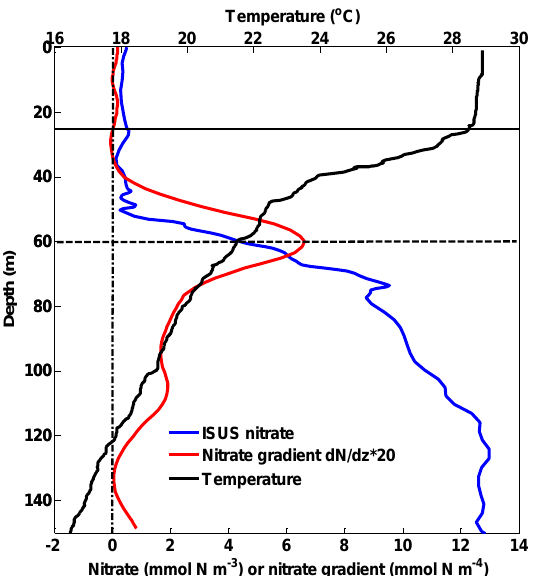
Figure 4. Vertical nitrate gradient; ISUS nitrate and temperature at SEATS station (2012, cast 36) (horizontal line indicates the depth of the surface mixed layer, horizontal dashed line indicates the depth of the nitracline and the vertical dash–dotted line represents zero nitrate